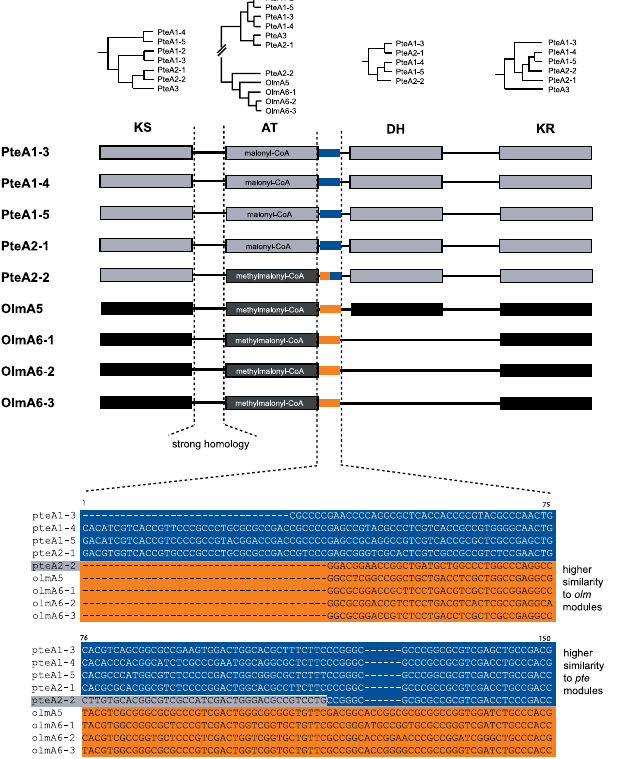
Figure 5. Replacement of an AT Domain The incongruent phylogenetic clustering of the PteA2–2 AT domain is displayed in the miniaturized trees. AT–DH interdomain regions are highlighted in blue and yellow to show the hybrid character of the PteA2–2 interdomain region. DOI: